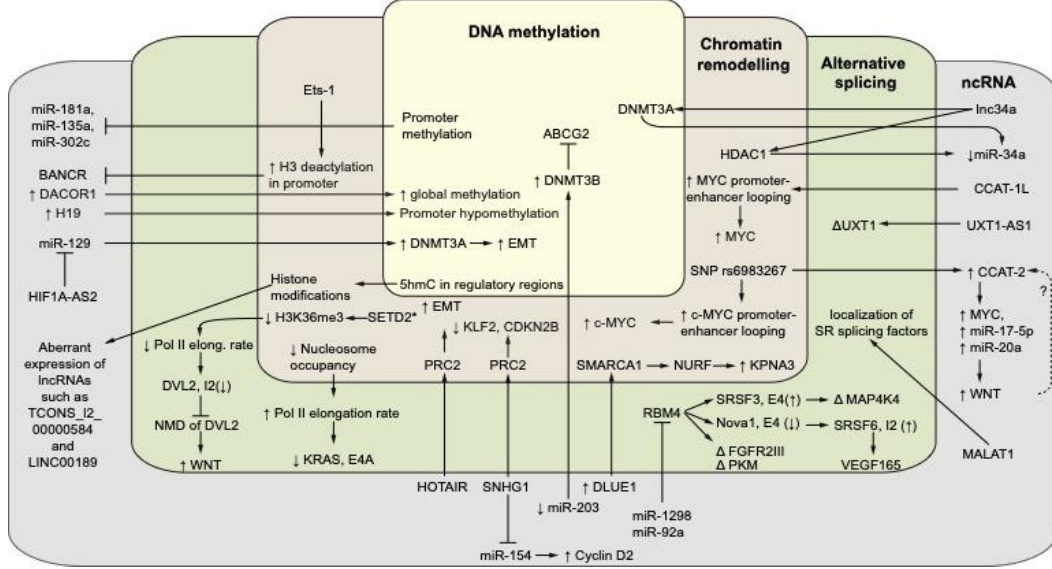
Figure 2. Overview of cross-talk between gene-regulatory layers in CRC. This figure depicts selected examples of the deregulated interplay between epigenetic events, alternative splicing (AS) and noncoding RNA in colorectal cancer. See the text of the manuscript for further details. ↑ and ↓ arrows represent up- or down-regulation or higher or lower activity of a factor, respectively. Intron and exons are abbreviated as E or I, respectively. In the cases of AS, ↑ and ↓ represent increased and decreased usage of an exon or intron, respectively. ∆ represents isoform switching of a transcript due to AS. SET2D* represents a mutant of SET2D. The dashed arrow with question mark (?) represents a predicted feedback loop between WNT and CCAT-2. A vector graphics version of this figure is provided as Supplementary Figure S1.